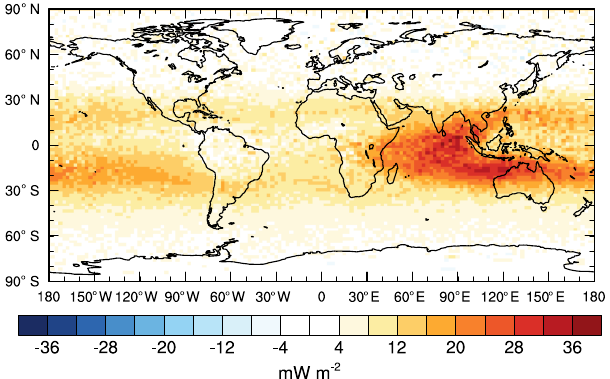
Figure 3. Annual-mean ozone forcing (mWm − 2 ) due to 1990– 2010 maritime Southeast Asian land cover